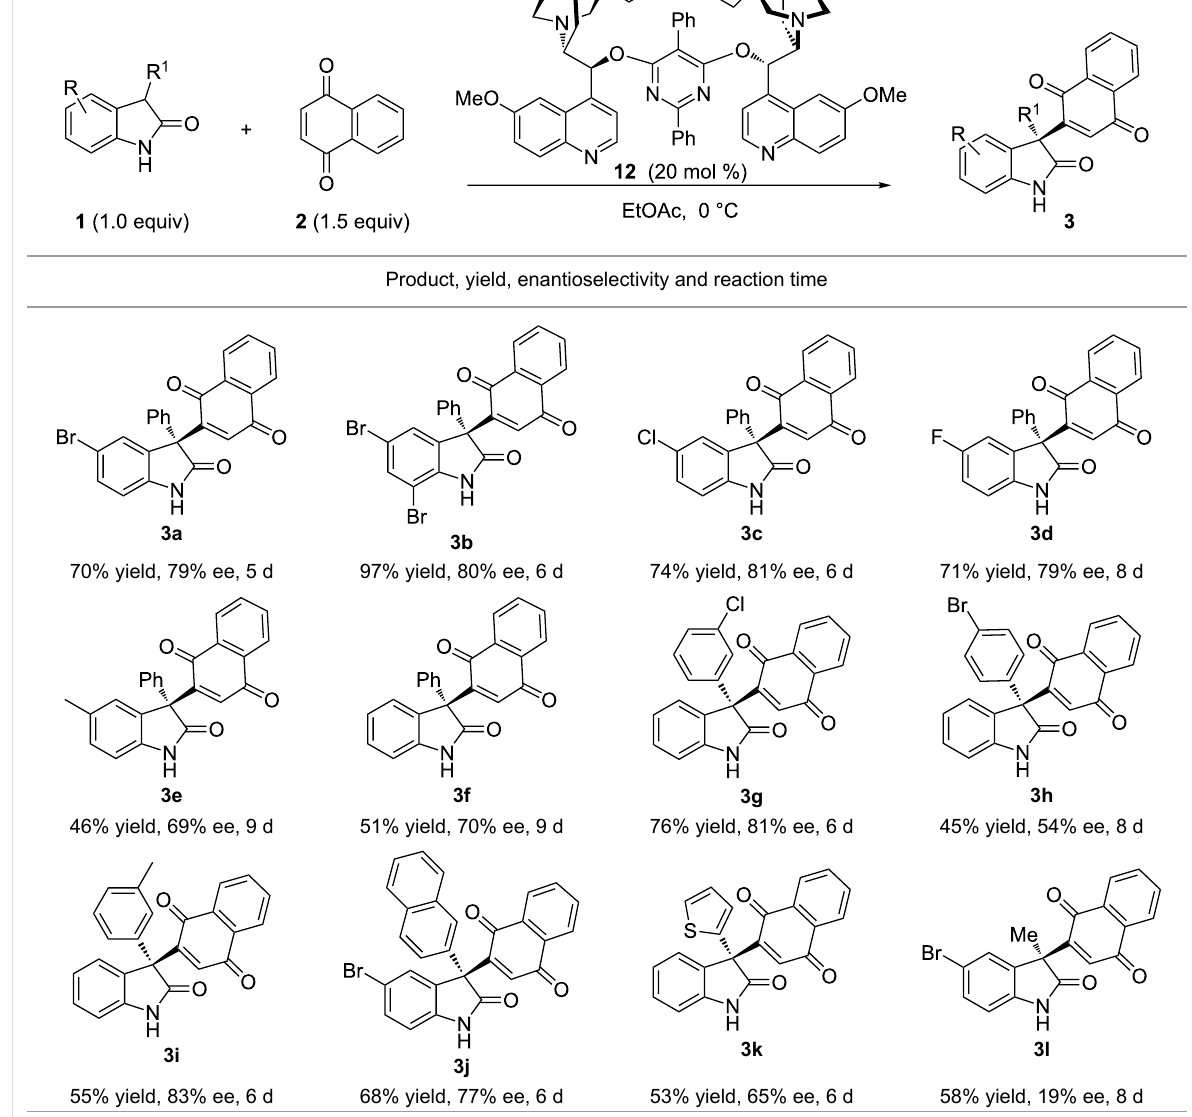
Table 2: Substrate scope of unprotected 3-prochiral oxindoles a–c .